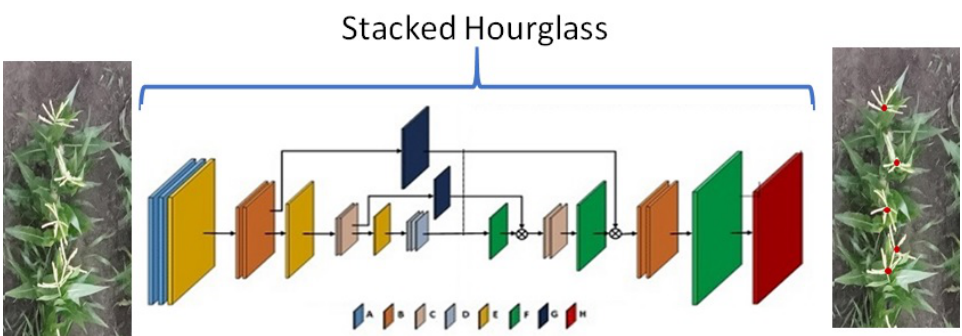
Figure 3. CenterNet Schematic “Hourglass-104 architecture and illustration of the heatmap for the input image. A and B are convolutional layers; C and D are inception modules; E is the max-pooling layer; F is the transposed convolutional layer; G is the residuals modules; H is the loss